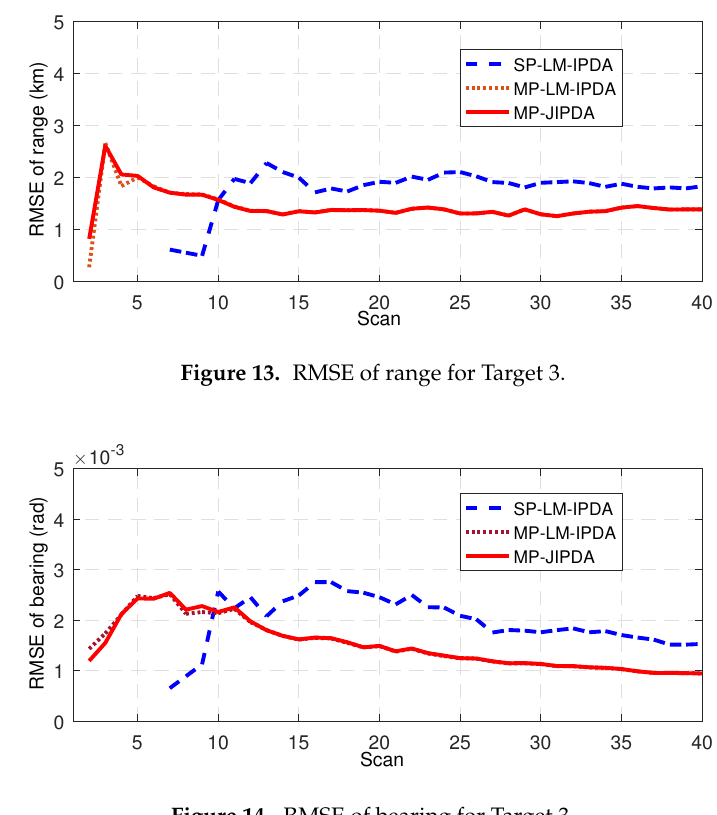
Figure 14. RMSE of bearing for Target